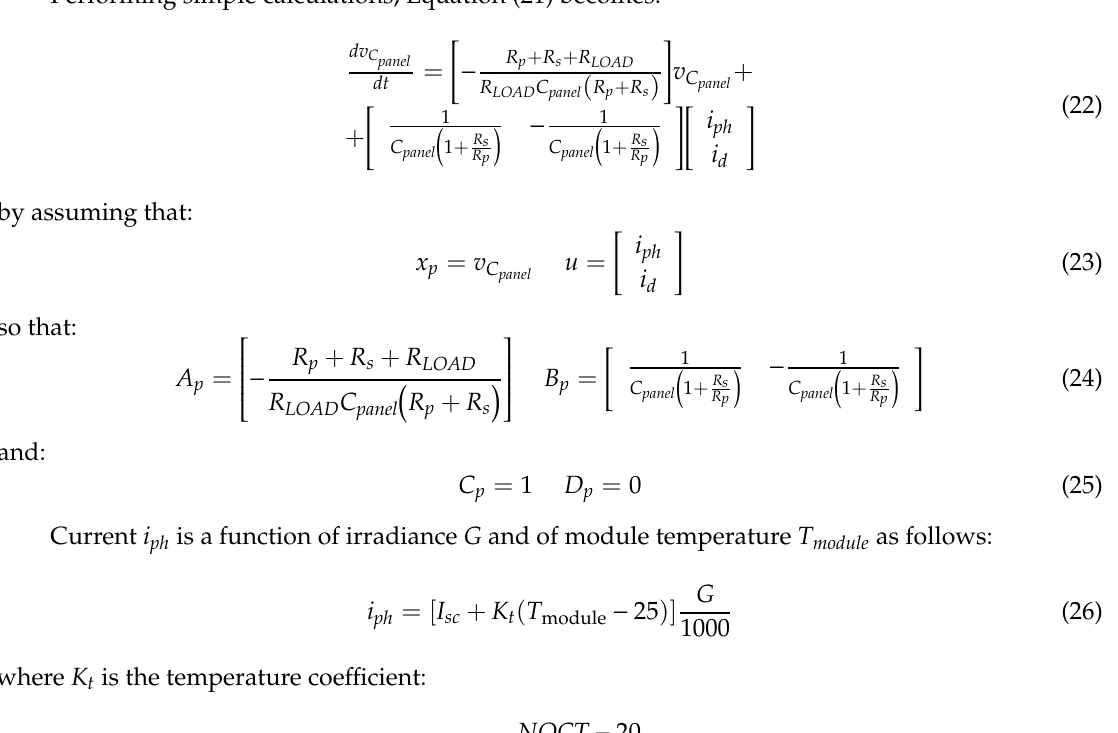
Figure 8. Simplified equivalent circuit used to build the basic state-space representation of the PV array.